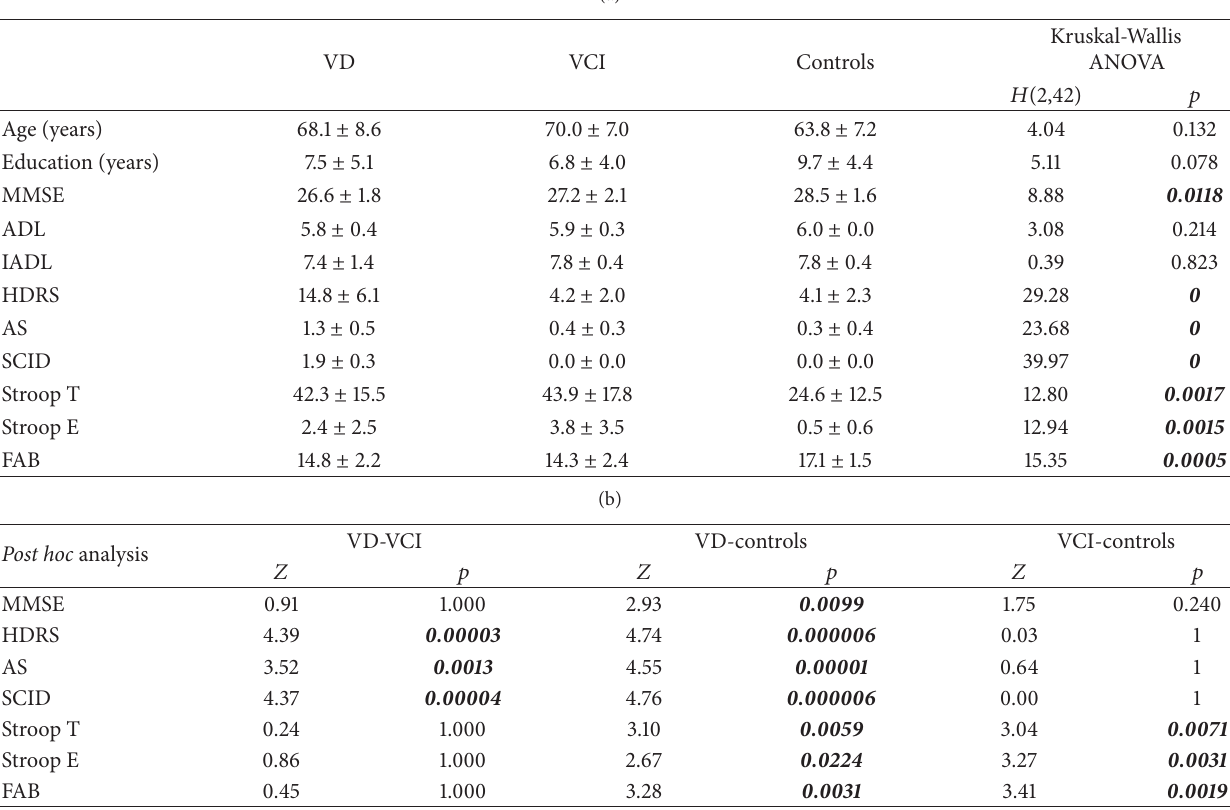
Table 1: Neuropsychological characteristics of the three groups at